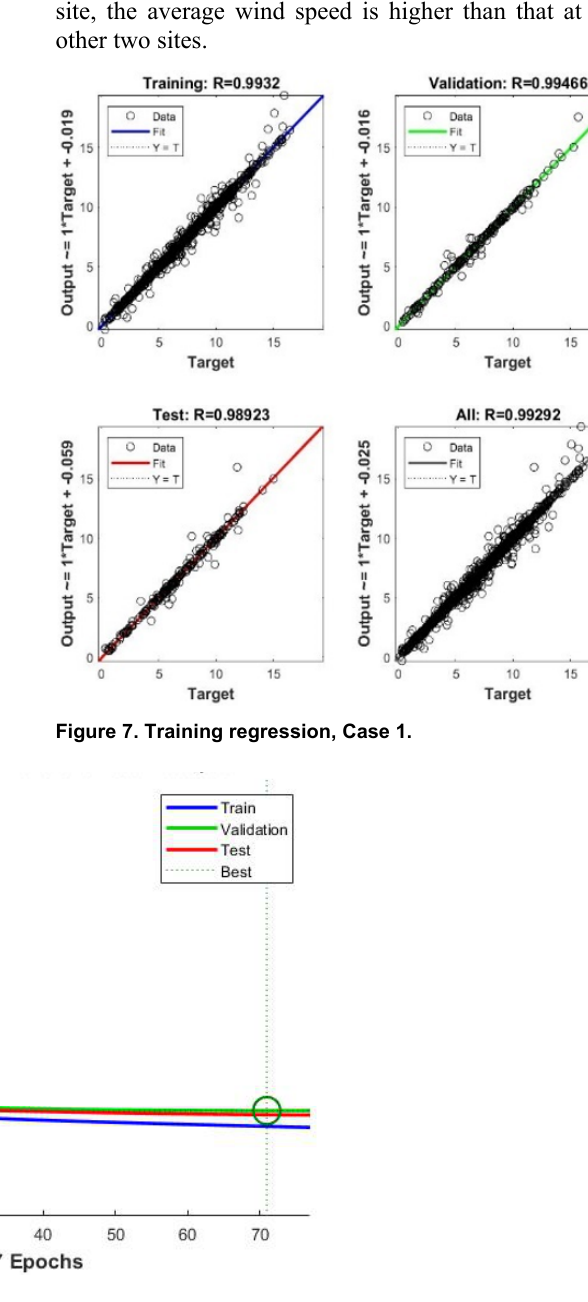
Figure 8. Performance validation, Case